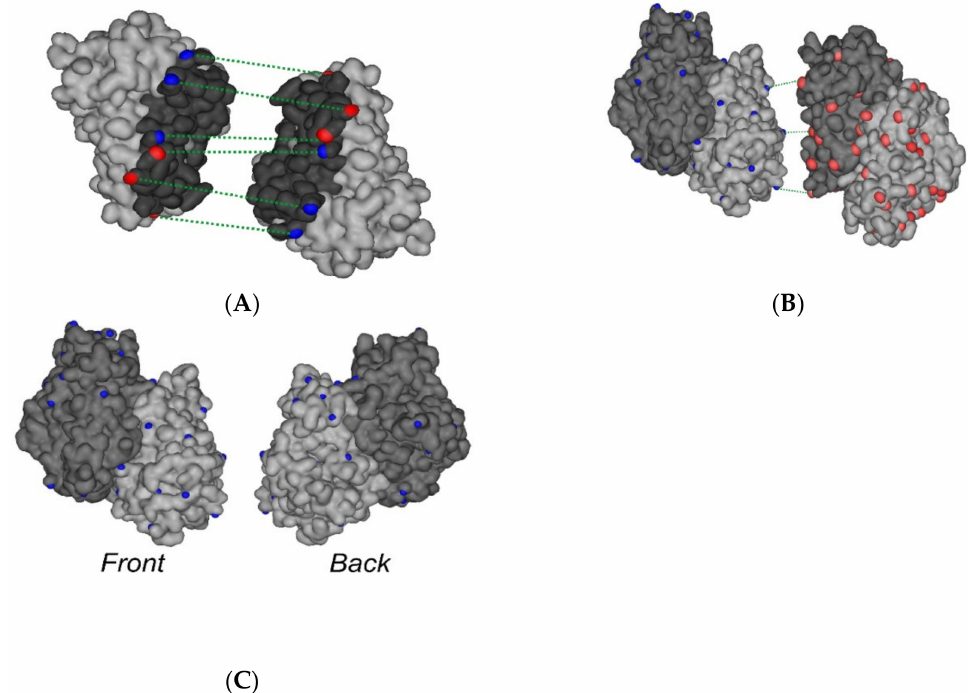
Figure 6. Visualization of 3D structure of ferrochelatase (FECH) protein (PDB ID 1HRK) with surface accessible chemical groups which can be critical for cross-linking between carboxyl groups of chip dextrane matrix and for intersubunit cross-linking. Surface lysine amino groups and carboxyl groups of ferrochelatase subunits are stressed with blue dots and red dots, respectively. Visualization was carried out using ViewerLite 5.0 software (Accelrys Inc., San Diego, CA, USA). ( A ) stabilization of FECH dimer via chemical cross-links between monomers in positions GLU255—LYS415, GLU292—LYS397, GLU289—LYS286, LYS286—GLU289, LYS397—GLU292 and LYS415—GLU255 is shown in